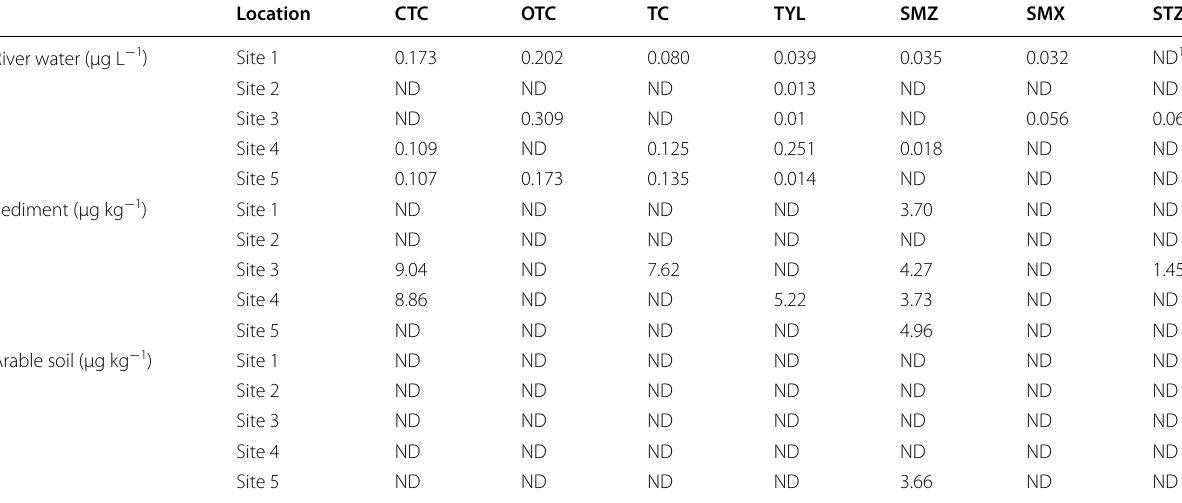
Table 4 Concentrations of target analytes in river water